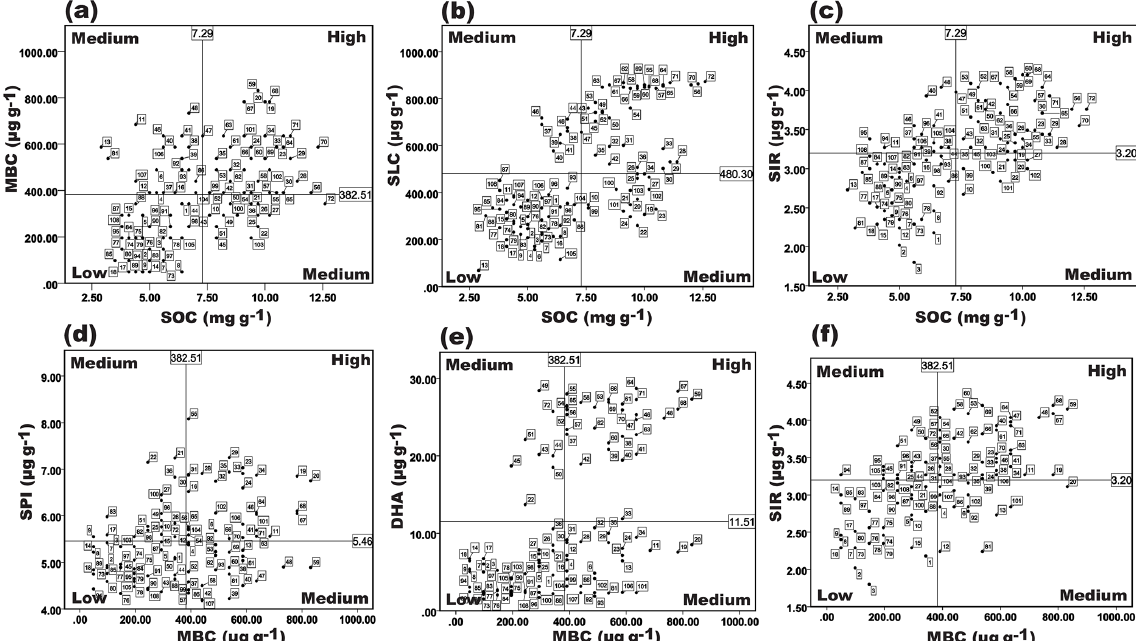
Figure 4. Quadrant scatter plots showing the relatedness of the soil biological variables in four different nutrient management enforced soils of three different agroclimatic zones of Tamil Nadu. Each scatter plot is divided into quadrants based on the mean of the respective axis, which is indicated in the plot. Quadrants with “High” show that both the variables are above the average; “Medium” means that any one of the variables is below the average; “Low” means that both the variables are below the average. The main variable is on the x axis and the second variable for it is on the y axis; 1–108 represent the soil